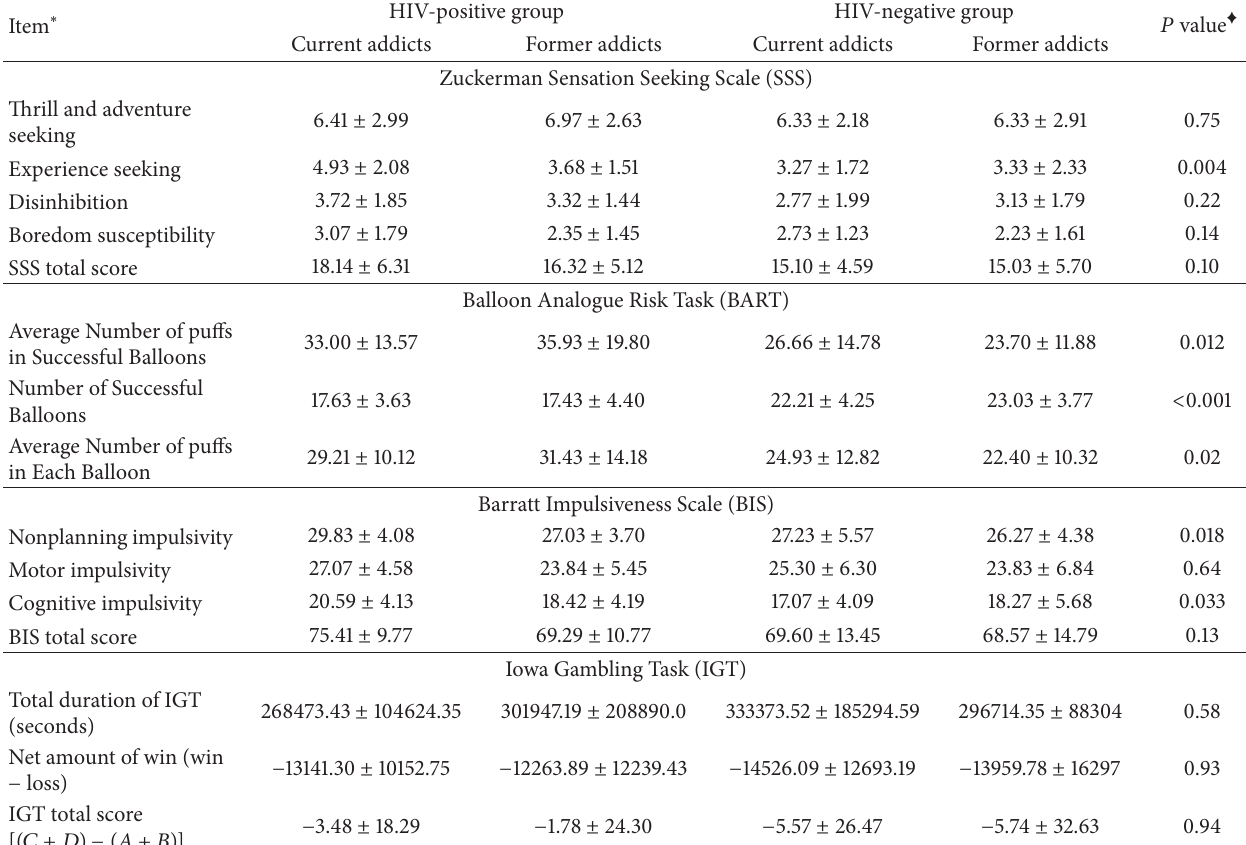
Table 3: Comparison of subscale scores in each test between current and former opiate addict HIV-positive and HIV-negative